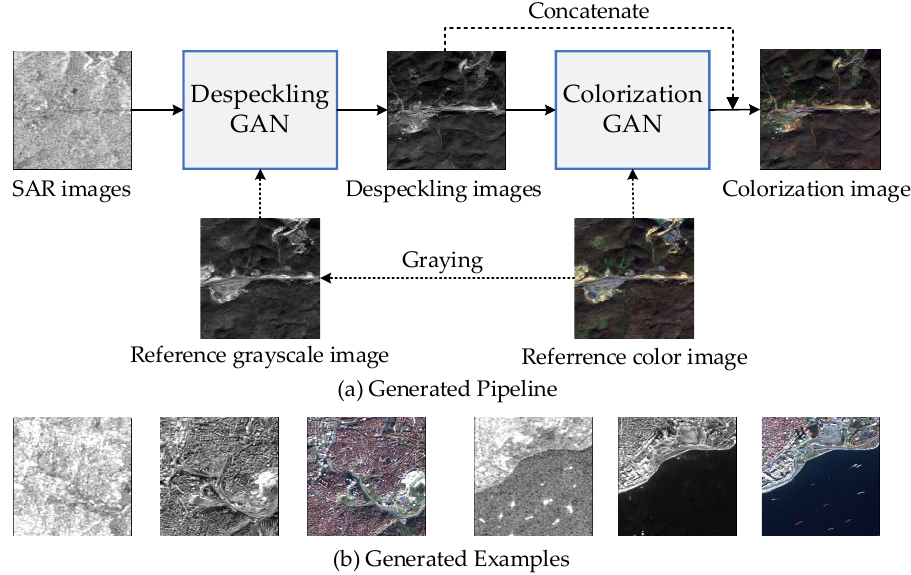
Figure 1. ( a ) Overview of our method: the SAR image affected by speckling is the input, and the Despeckling GAN generates a corresponding optical grayscale image as output. The optical grayscale image is then sent as input to the second generator network Colorization GAN, and the output is an optical color image. ( b ) Examples of generating optical grayscale images and optical color images through the Serial GANs.